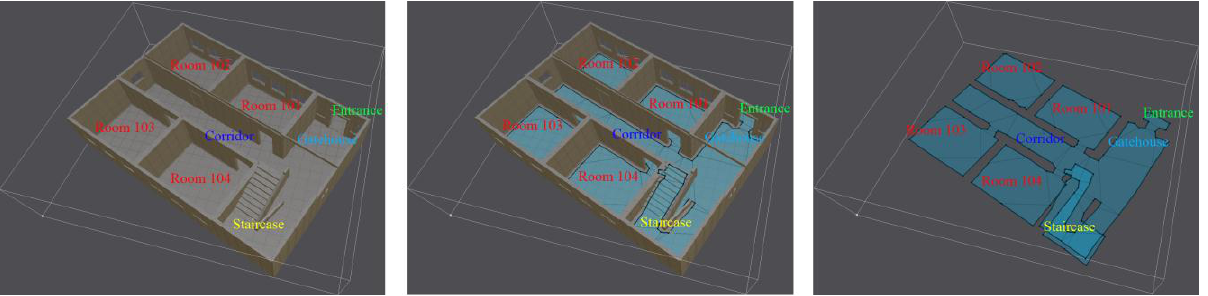
Figure 5 The experiment building model and navigation mesh